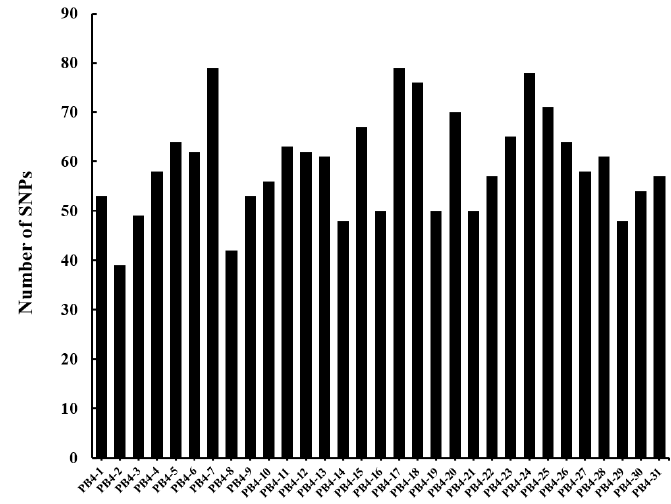
Figure 5. SNPs in the single-ascospore-isolation offspring of strain PB4 compared with strain PB4.